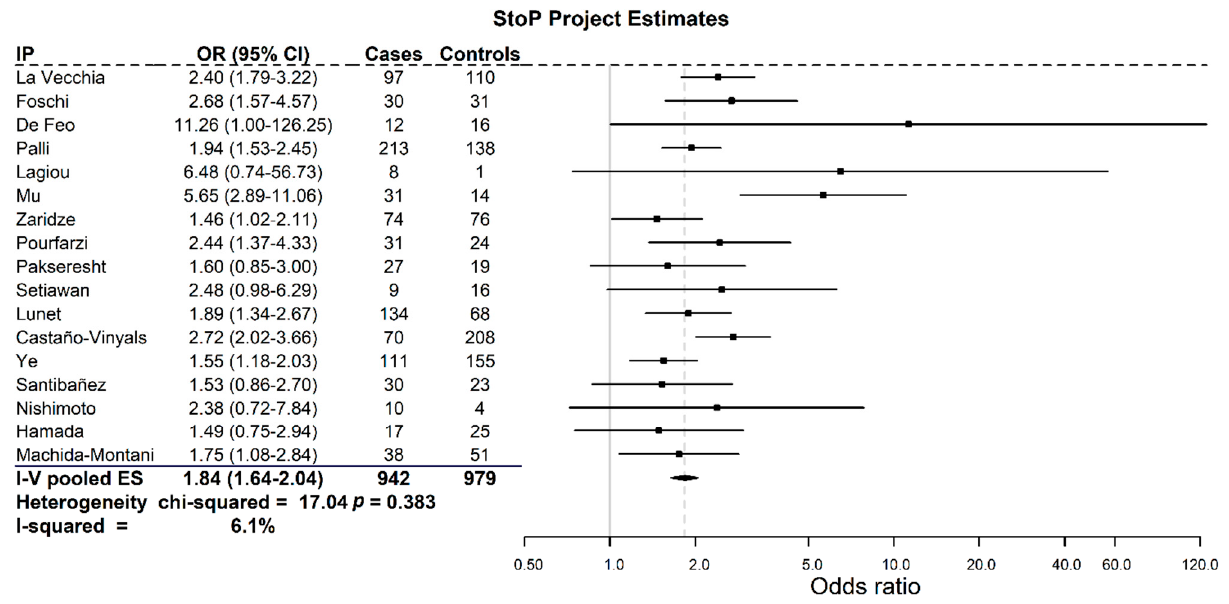
Figure 1. Pooled adjusted odds ratios with 95% confidence intervals for GC related to family history in the StoP Project.